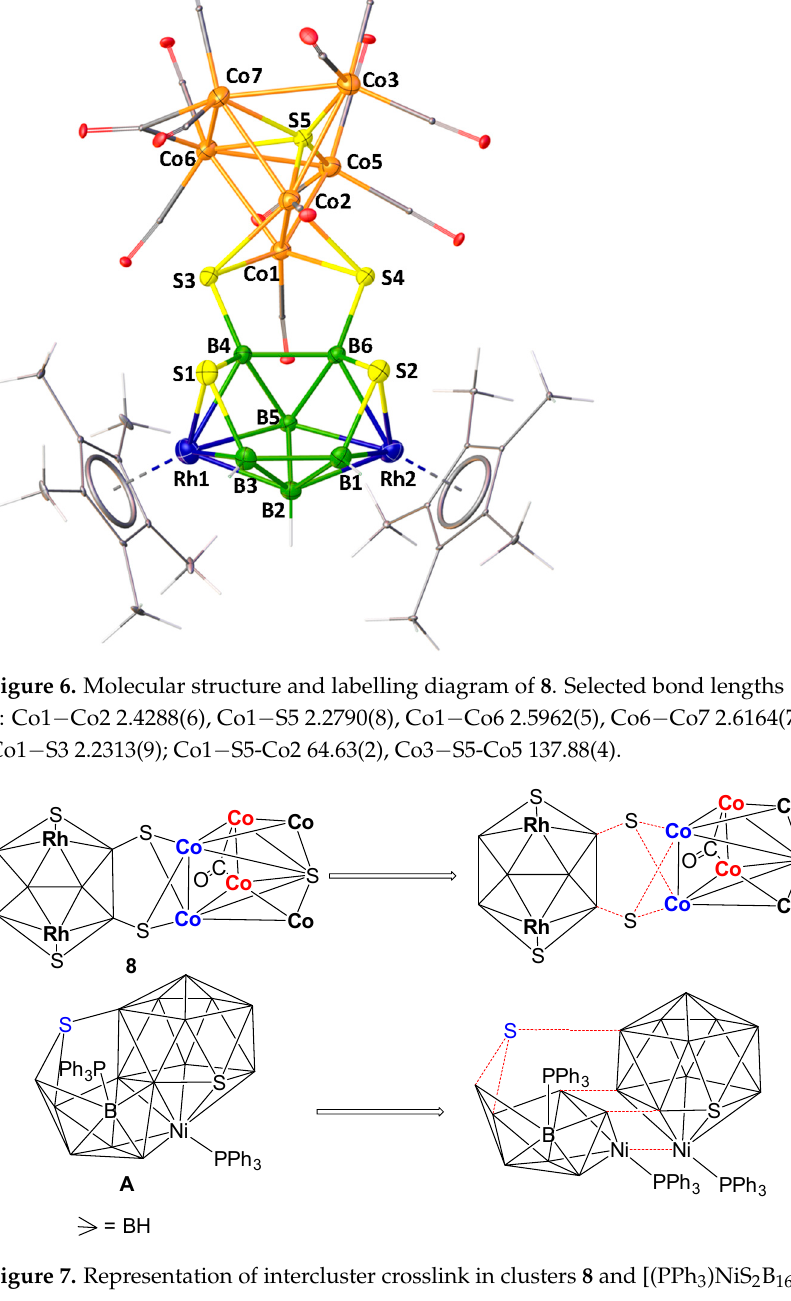
3 )NiS 2 B 16 H 12 (PPh 3